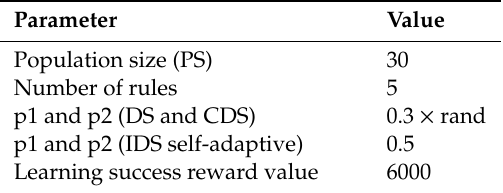
Figure 6. The training environment. Table 1. Initialization parameters before the training.